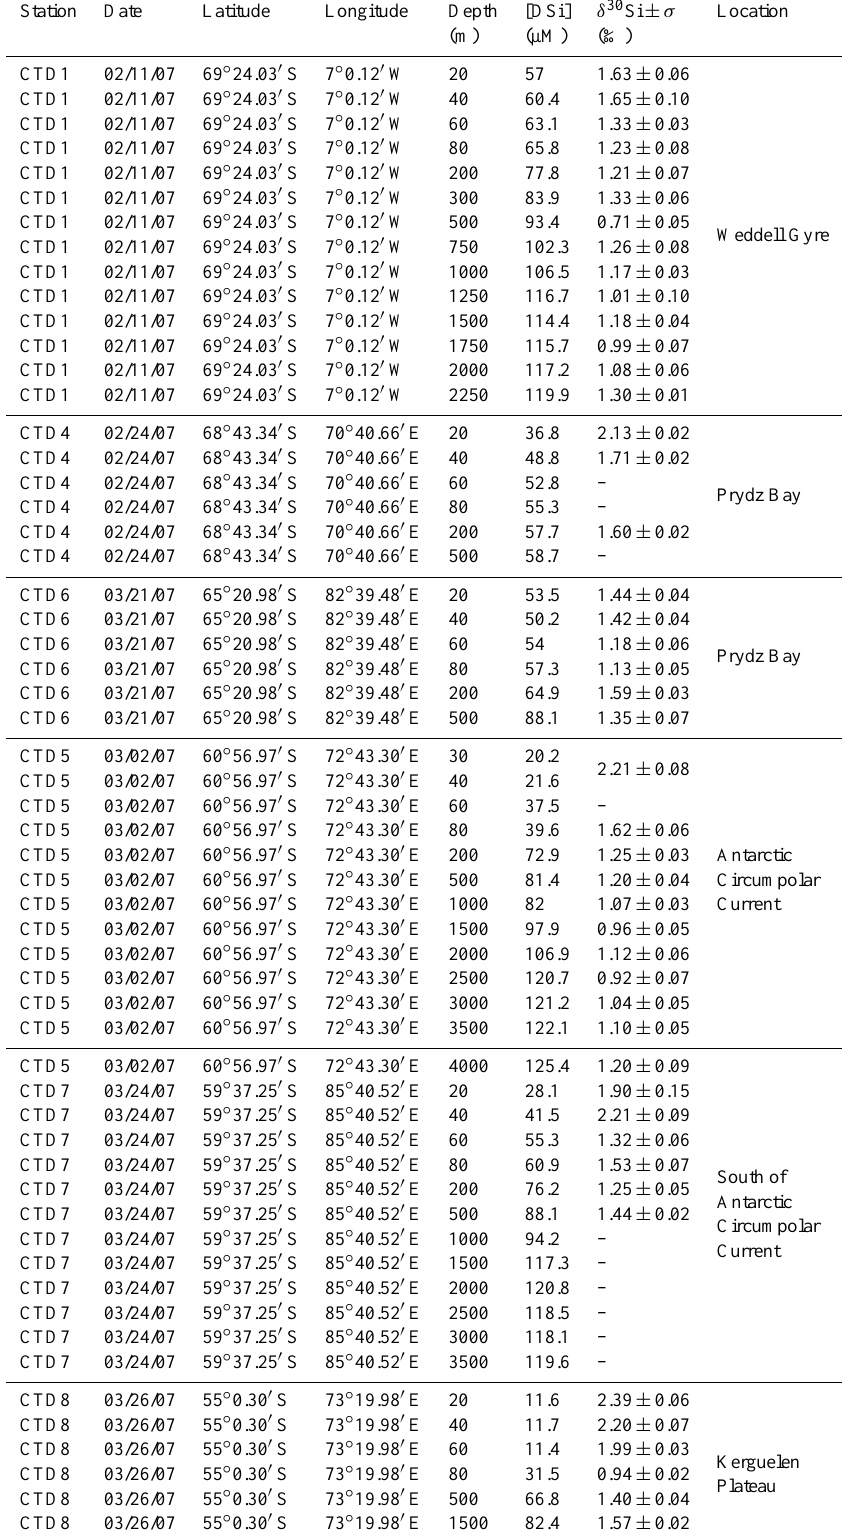
Table A1. Data for water samples from